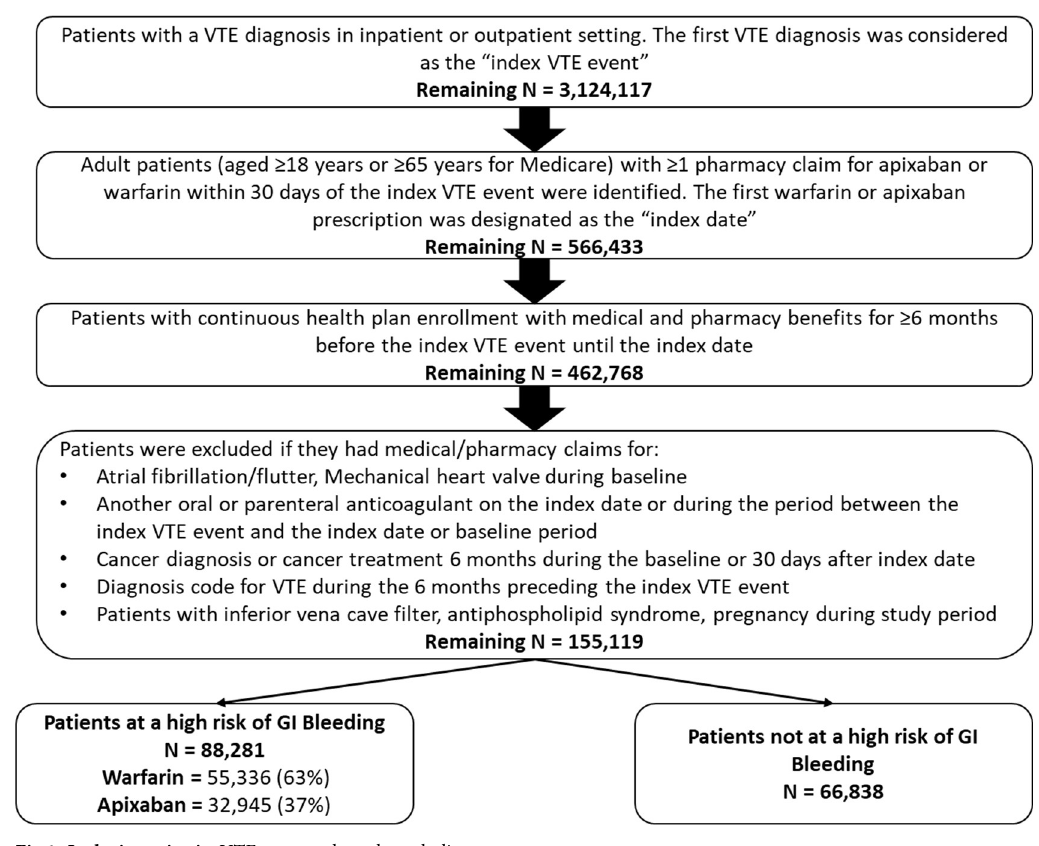
Fig 1. Inclusion criteria. VTE: venous